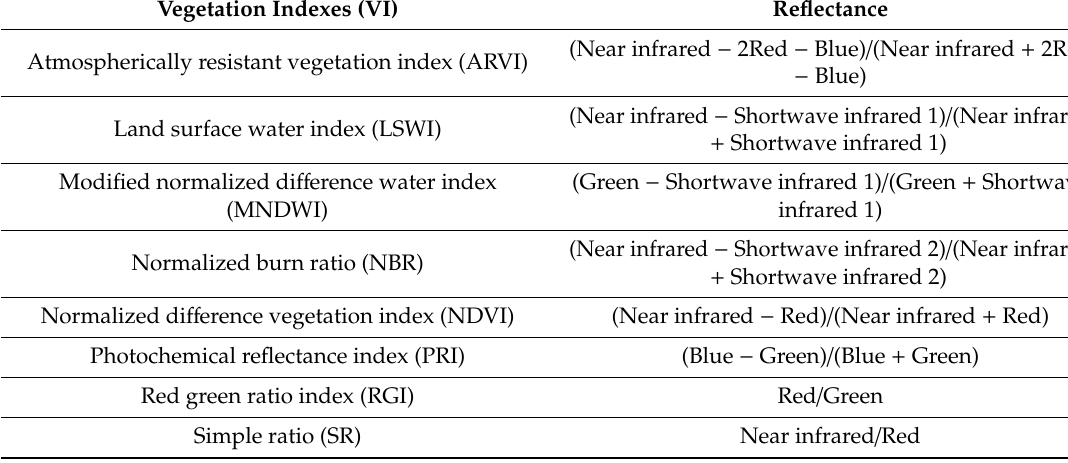
Table 2. Vegetation indexes (VI) calculated from the reflectance data of the Landsat-8 Operational Land Imager (OLI) satellite bands for the detection and monitoring of leaf-cutting ant nests in Tectona grandis